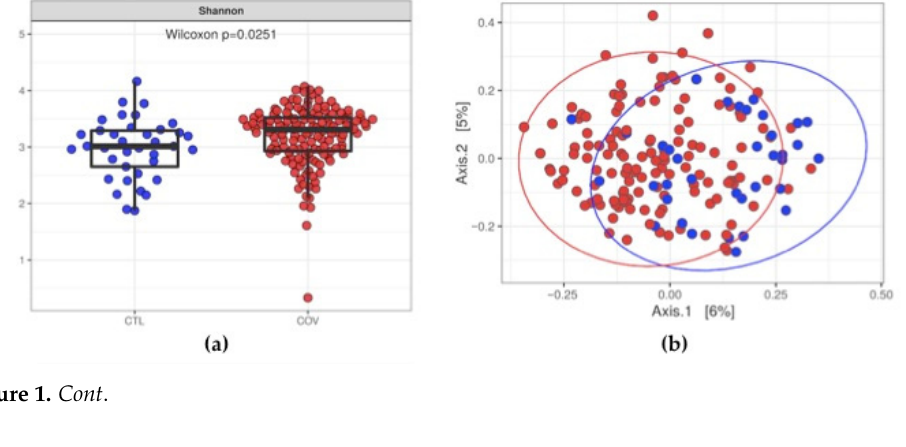
Figure 1. Diversity analysis of the intestinal microbiota from post-COVID-19 patients (COV) and control subjects (CTL). ( a , c ) Shannon indices showing the evenness of the intestinal microbiota, and ( b , d ) Principal Coordinate Analysis (PCoA) plots showing the differences in microbiota diver- sity between post-COVID-19 patients and control subjects.